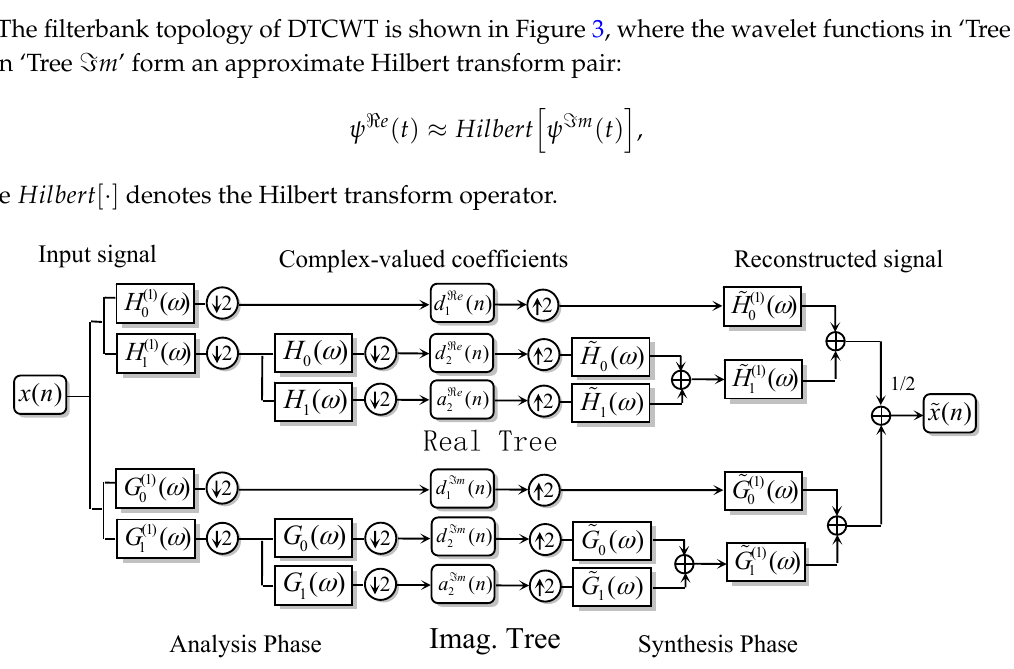
Figure 3. The analysis phase of DTCWT.